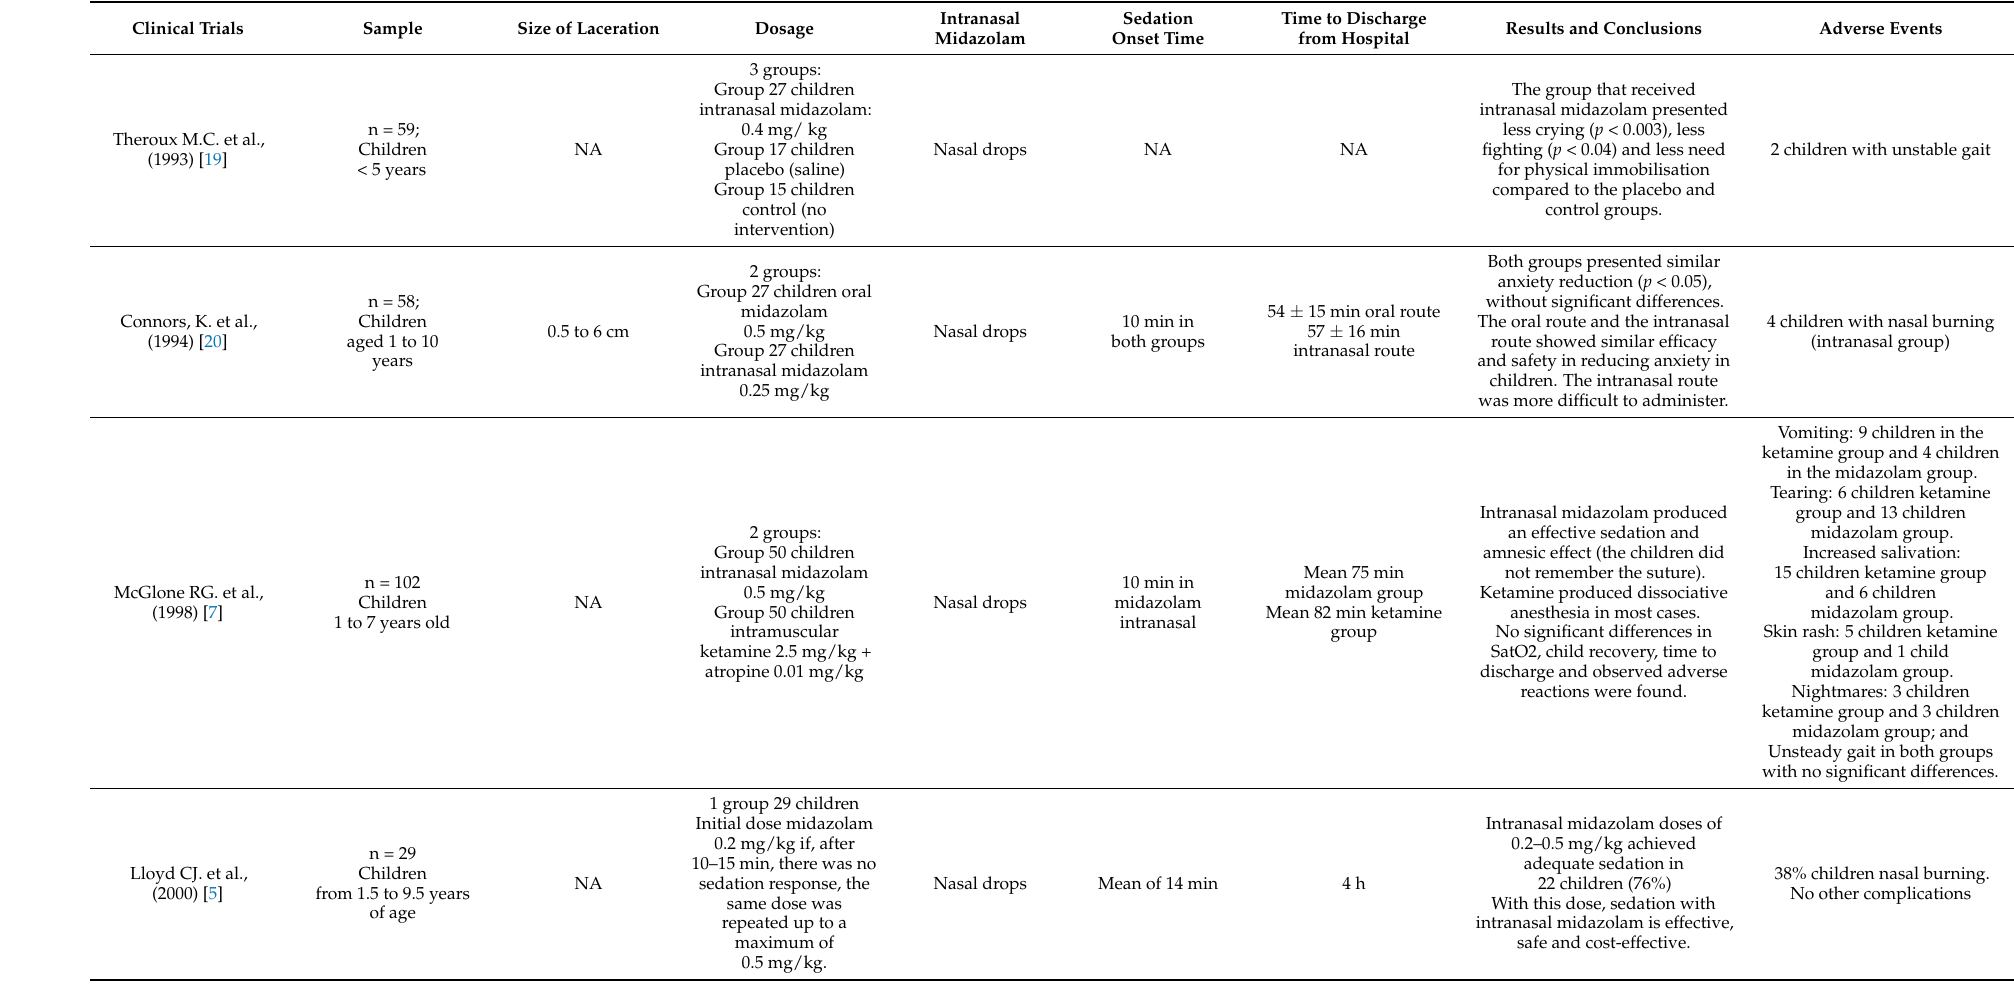
Table 5. Characteristics of the included